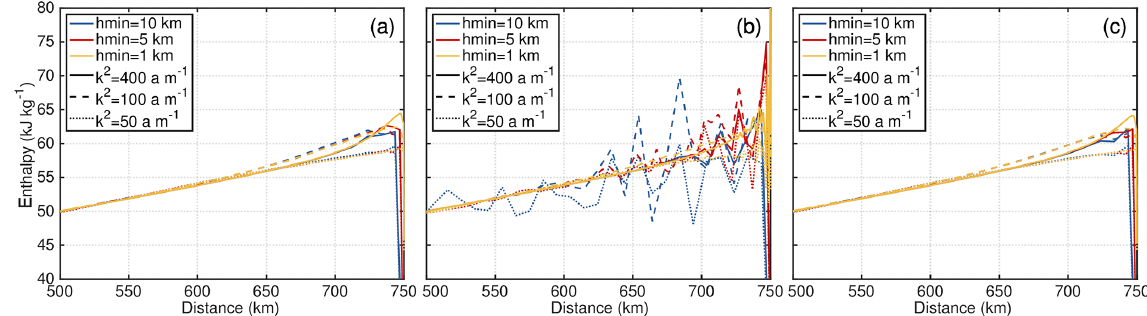
Figure 6. Simulated depth-averaged enthalpy (kJkg − 1 ) for the ice dome experiment along a cross section. (a) SUPG maxK, (b) SUPG minK, (c) ASUPG. The location of the cross section is shown in Fig. 4c.